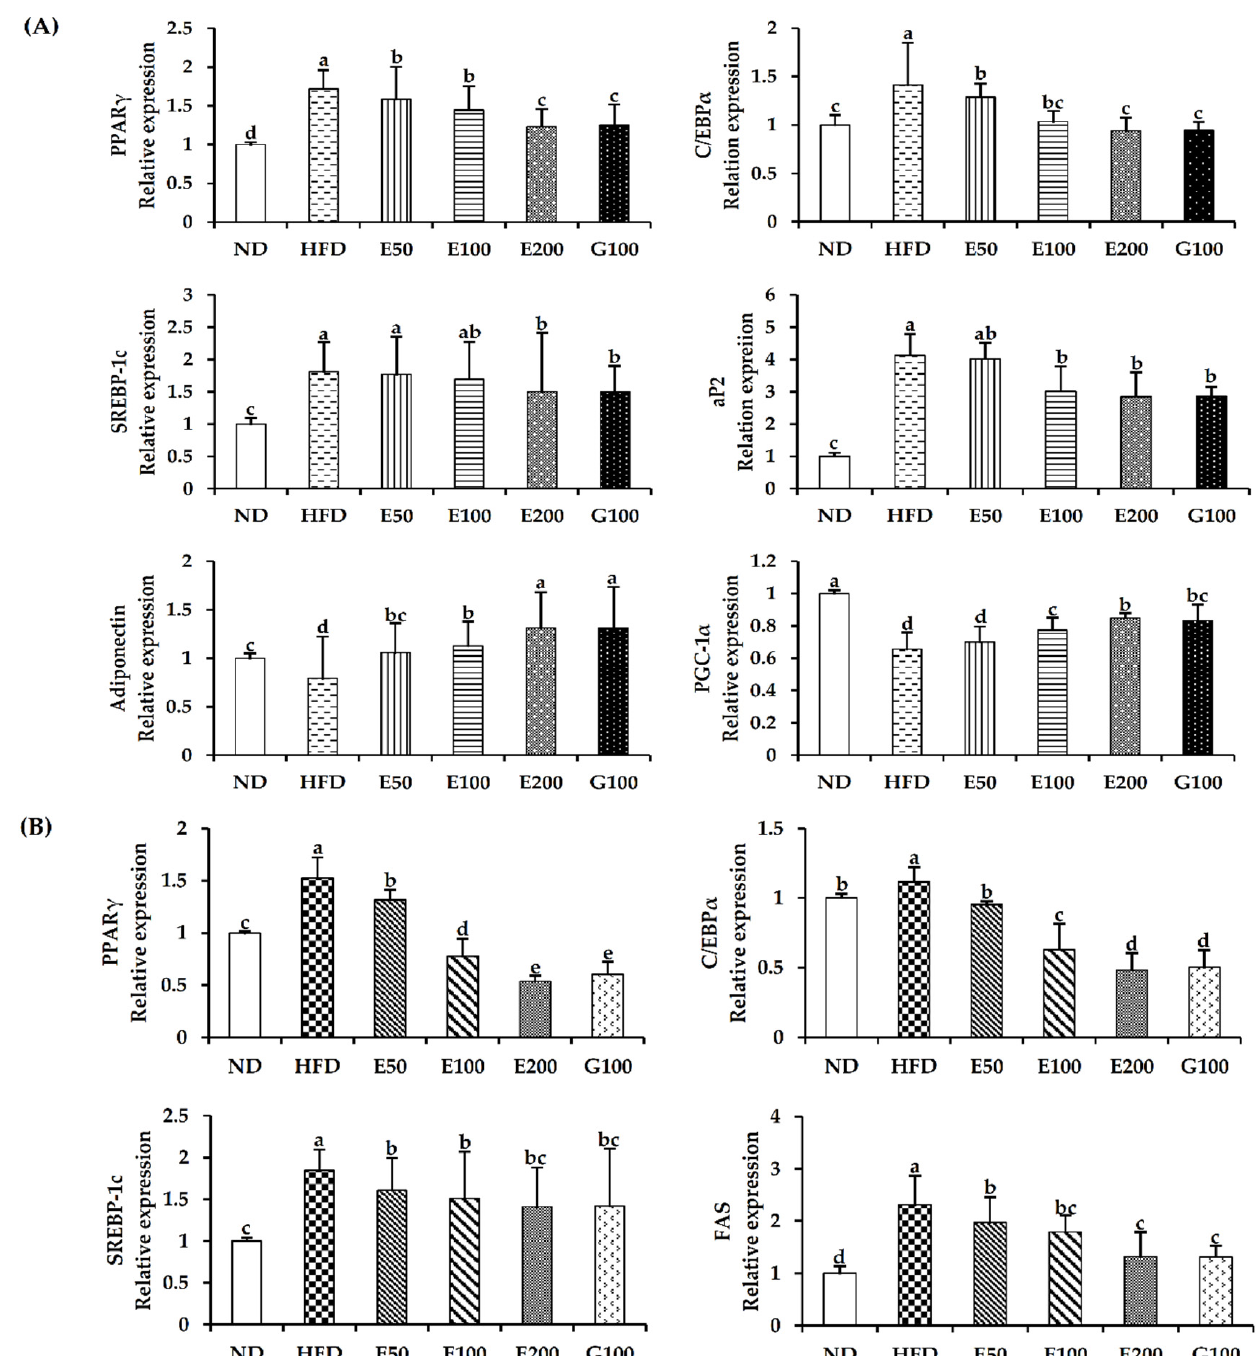
Figure 3. Effect of EAW on the expression of adipogenic and lipogenic genes in epididymis adipose tissues ( A ) and liver ( B ). Total RNA was extracted from epididymis adipose tissue and liver and subjected to real-time PCR analyses using primers specific for PPAR γ , C/EBP α , aP2, FAS, PGC-1 α , adiponectin, and SREBP-1c. Values are expressed as mean ± SD ( n = 3). Different lowercase alphabets indicate that differences between means were considered statistically significant when p < 0.05. ND, normal diet mice group (10% fat); HFD, high-fat (60% fat) diet-induced obese mice group; E50/100/200, high-fat diet-induced obese mice were orally treated with Erigeron annuus (L.) Pers. water extract (EAW) at concentrations of 50/100/200 mg/kg/day; G100, high-fat diet-induced obese mice were orally treated with Garcinia cambogia water extract at concentrations of 100 mg/kg/day.